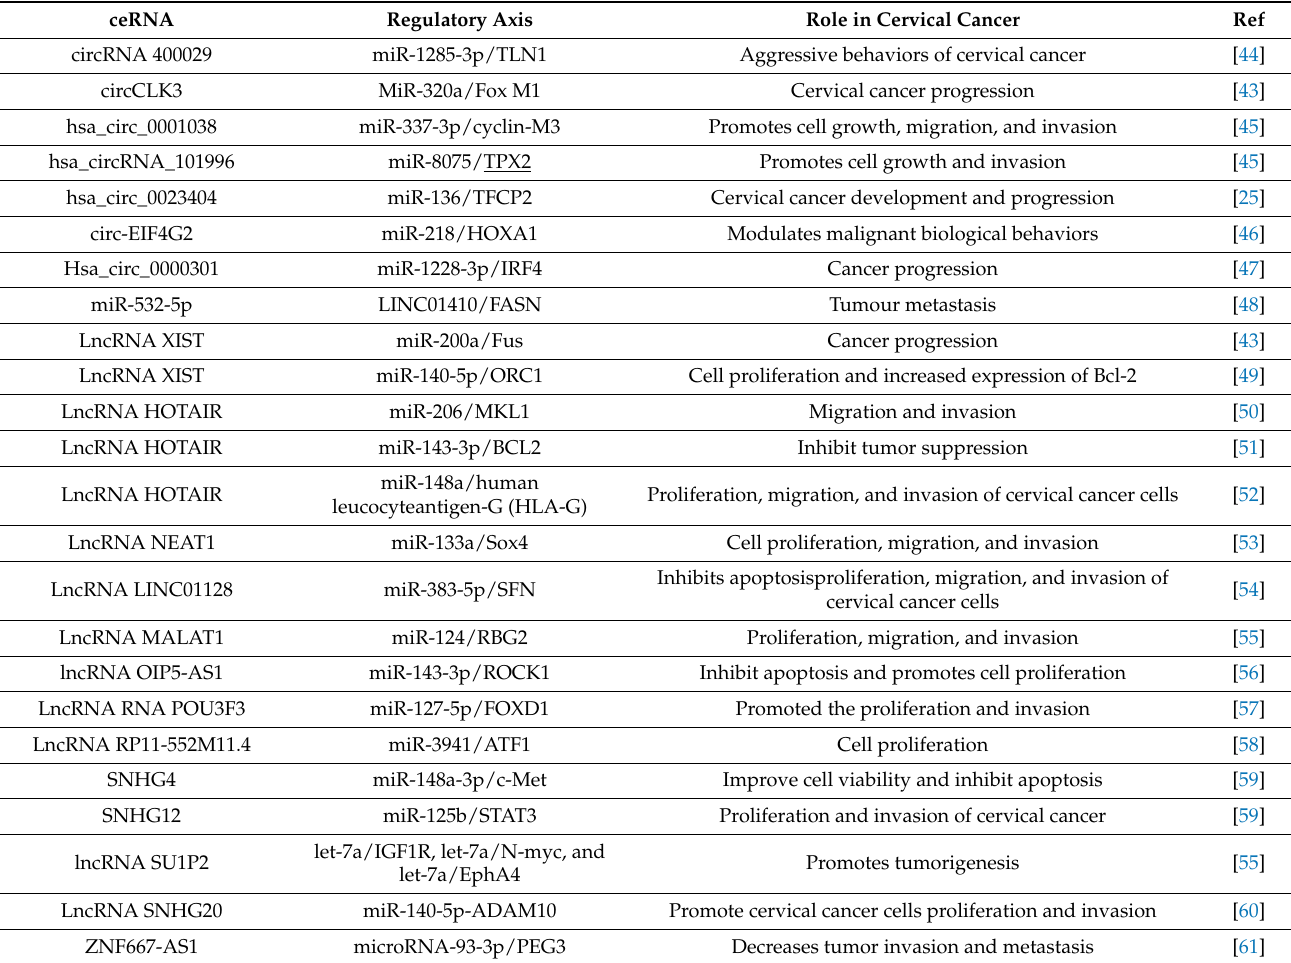
Table 1. CeRNA regulatory axis in cervical